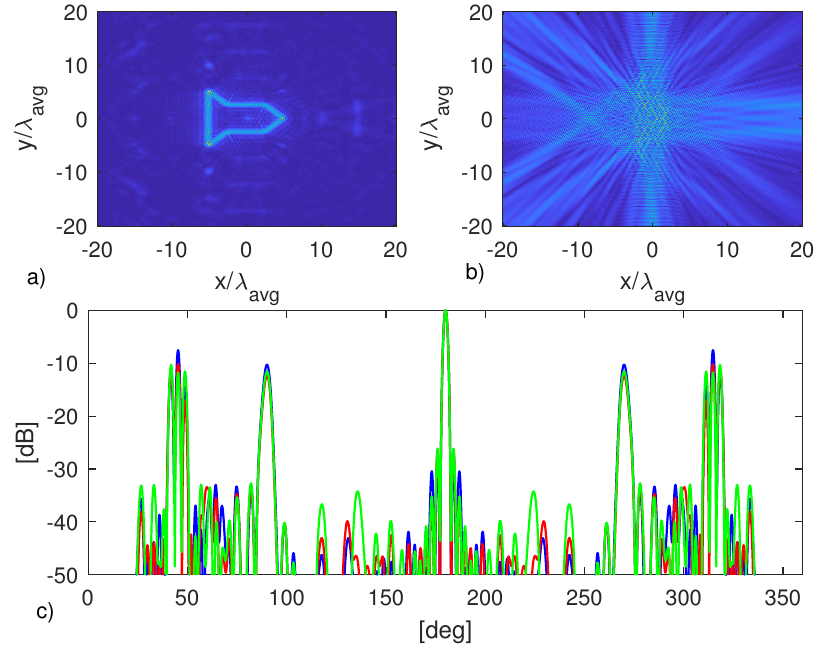
Figure 8. Object in Figure 5c. ( a ) Multi-frequency image. ( b ) Single-frequency image. ( c ) Normalized RCS at f = 4.5 GHz. The green line refer to the actual RCS, while the blue and red lines to the ones computed from the multi-frequency and single-frequency images,